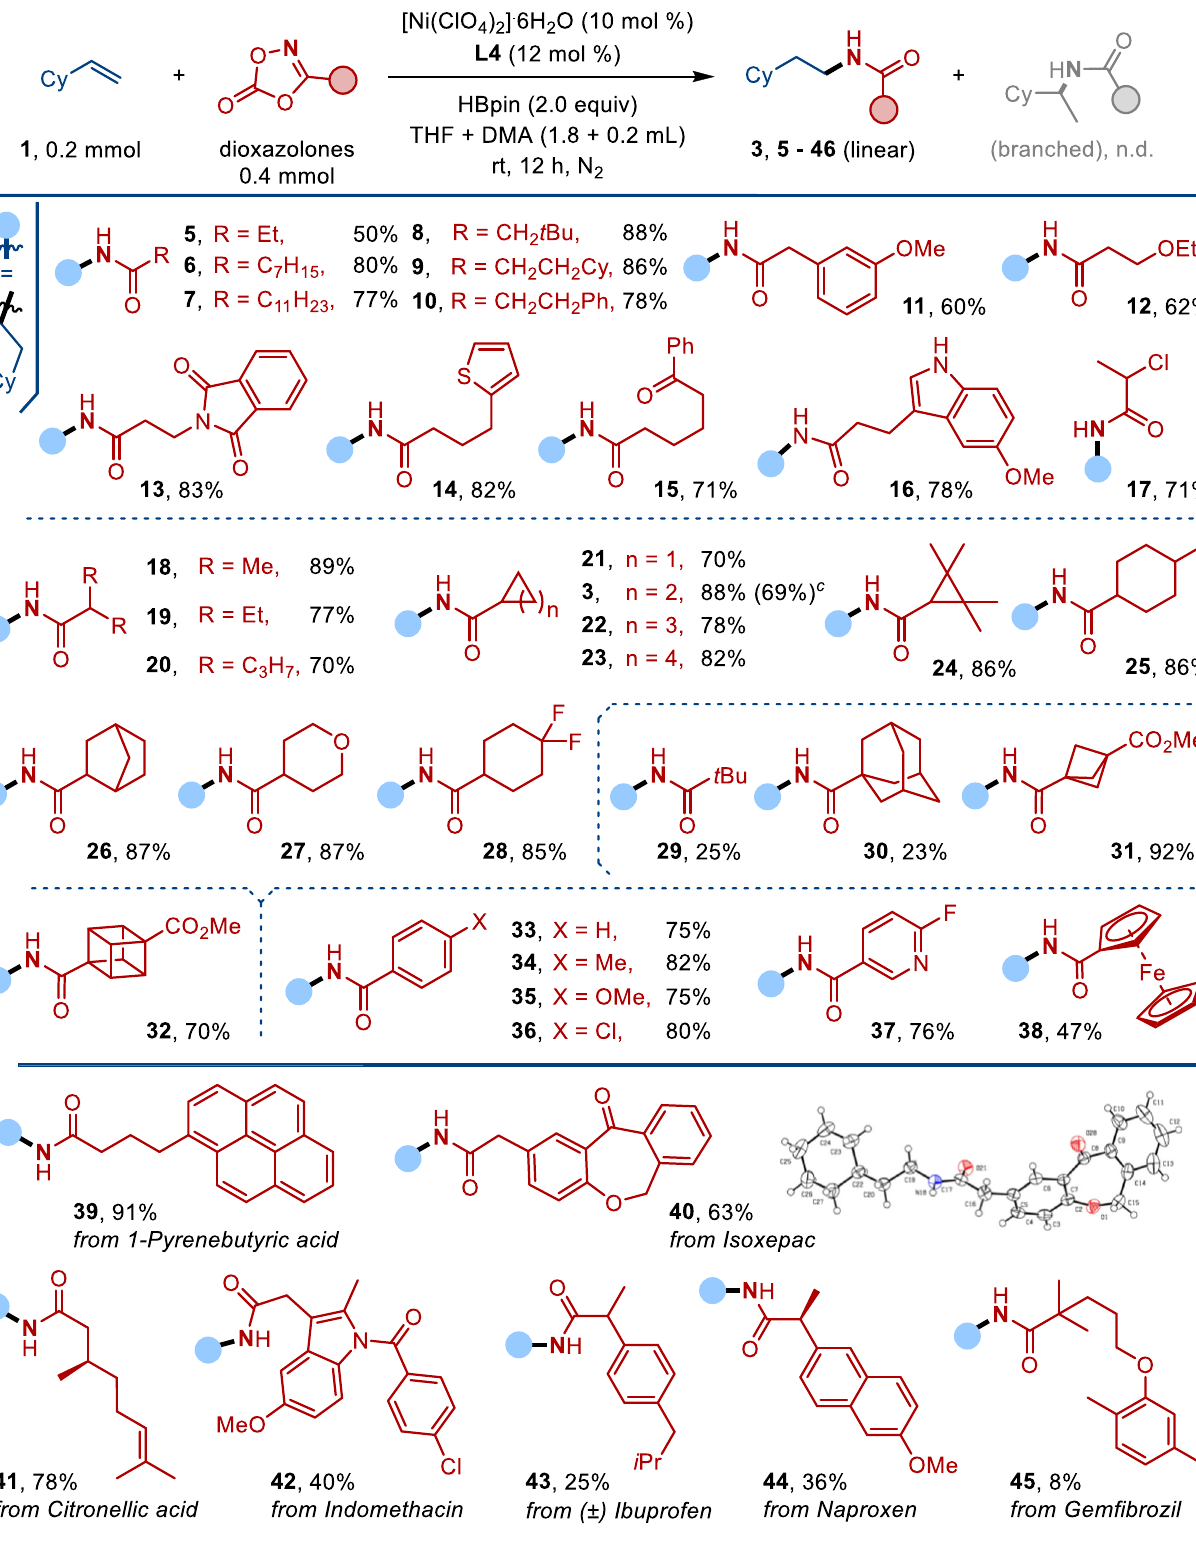
Fig. 2 Scope of dioxazolones. a Reaction conditions: 1 (0.2 mmol), dioxazolones (0.4 mmol), [Ni(ClO 4 ) 2 ] ∙ 6H 2 O (10 mol %), L4 (12 mol %), HBpin (2.0 equiv), THF + DMA (1.8 + 0.2 ml) in N 2 at room temperature for 12 h unless otherwise speci fi ed. b Isolated yield. c Large scale reaction: 1 (10.0 mmol) was used, 3 was obtained in 1.45